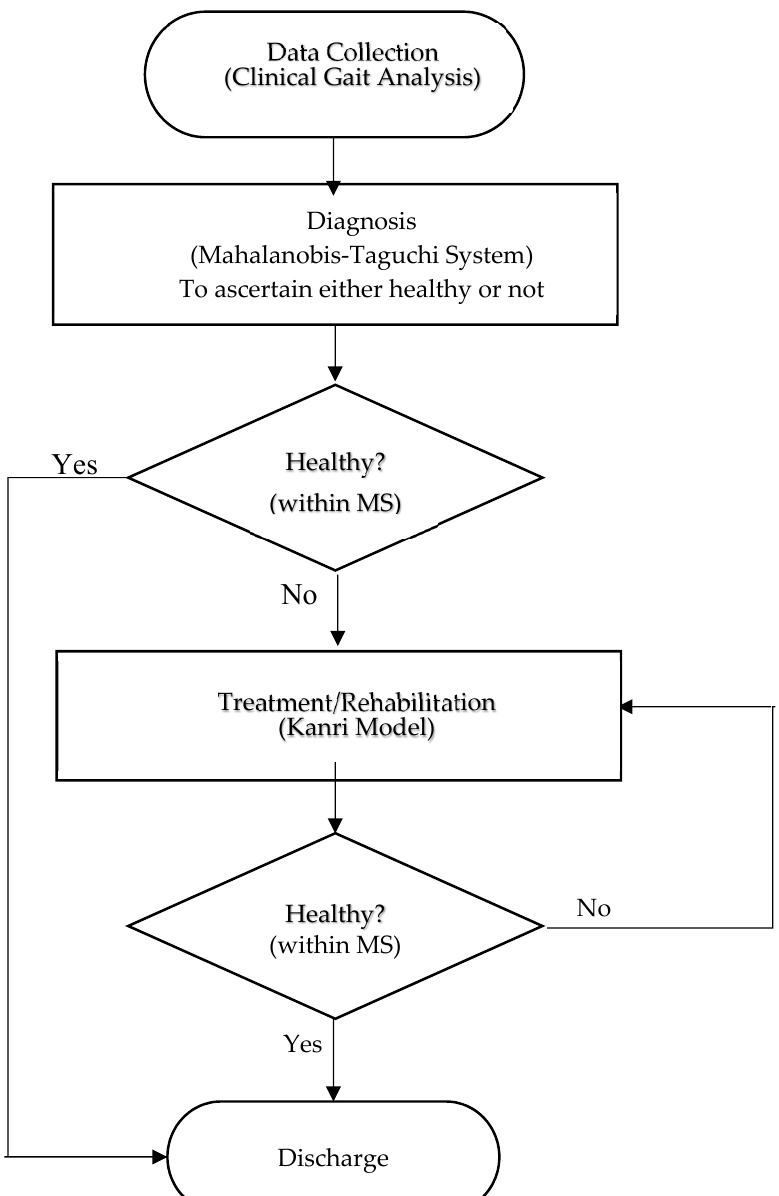
Figure 1. Flow chart of integrated gait abnormality detection approach based on MTS and the Kanri model.